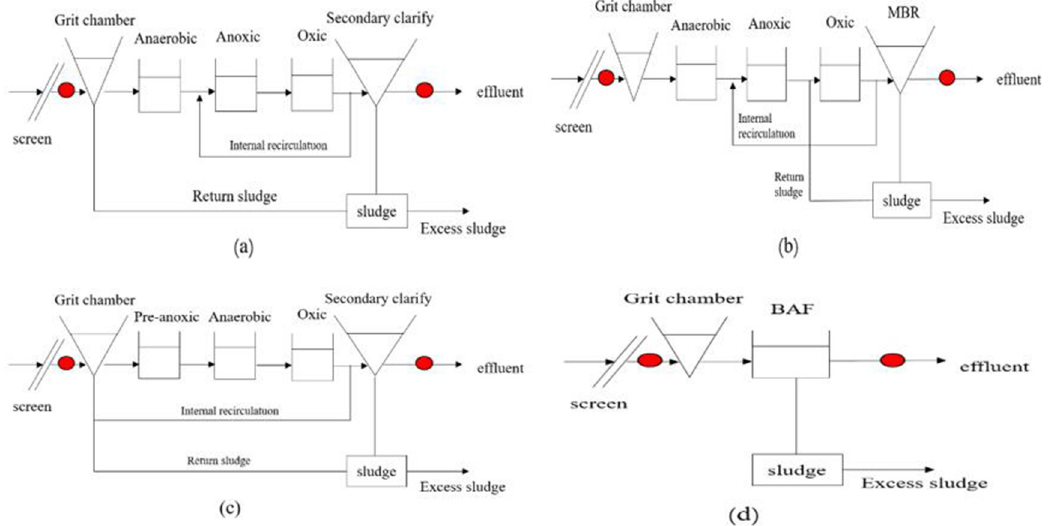
Fig 2. Flow charts of technological processes and sampling sites of four PMFs. (a) PMF1, A 2 O, (b) PMF2, MBR, (C) PMF3, modified AO, and (d) PMF4,